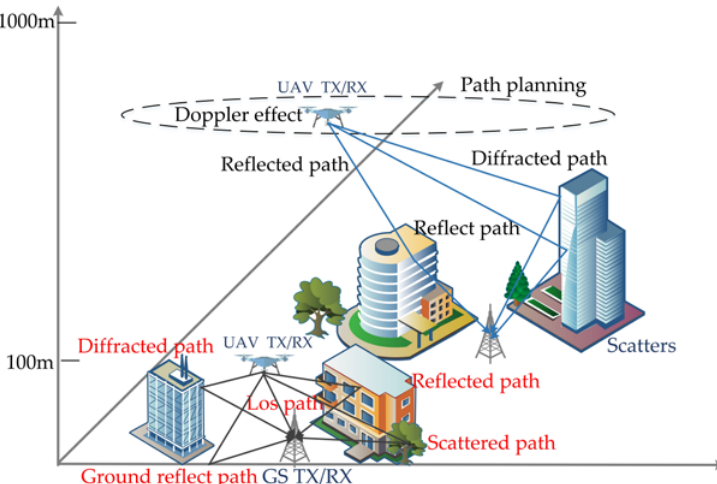
Figure 1. The analysis of channel characteristics.